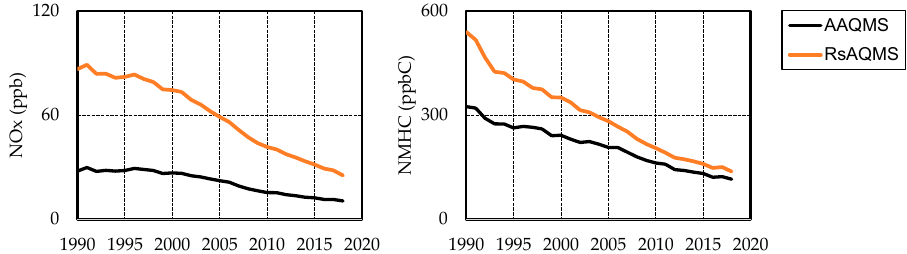
Figure 6. Annual average NOx and NMHC concentrations at the AAQMS and RsAQMS of the nation from 1990 to 2018.